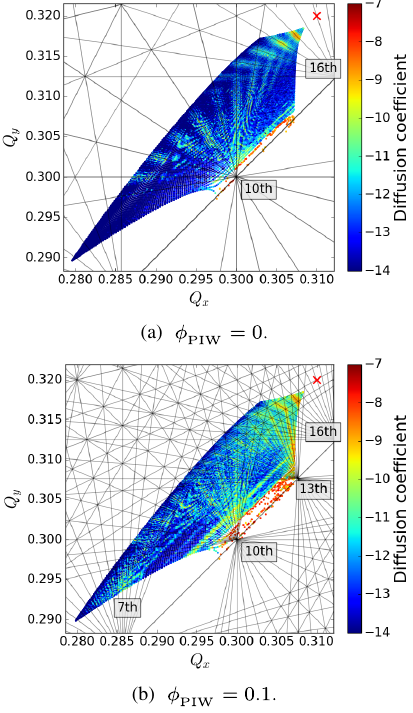
, when Tot FIG. 17. FMAs illustrating canceling of resonances using an intermediate phase advance μ 1 ¼ 0 . 512 · π , for a working point of ð Q x ; Q y Þ ¼ ð 0 . 31 ; 0 . 32 Þ , Q 0 ¼ 0 and ξ Tot ¼ 0 . 03 . Possible reso- nance lines up to the 16th order have been added, in addition to a few labels meant to guide the